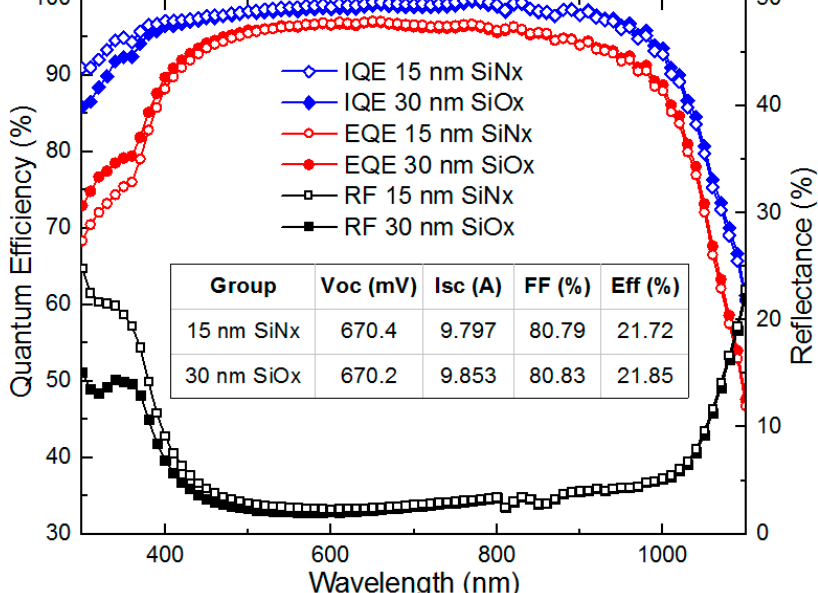
Figure 7. Reflectance (RF), external quantum efficiency (EQE), and internal quantum efficiency (IQE) curves of monocrystalline silicon PERC solar cells with the 15 nm SiN x third layer and the 30 nm SiO x third layer as the antireflection coating. The mean photovoltaic parameters of each group containing about 400 solar cells are listed.